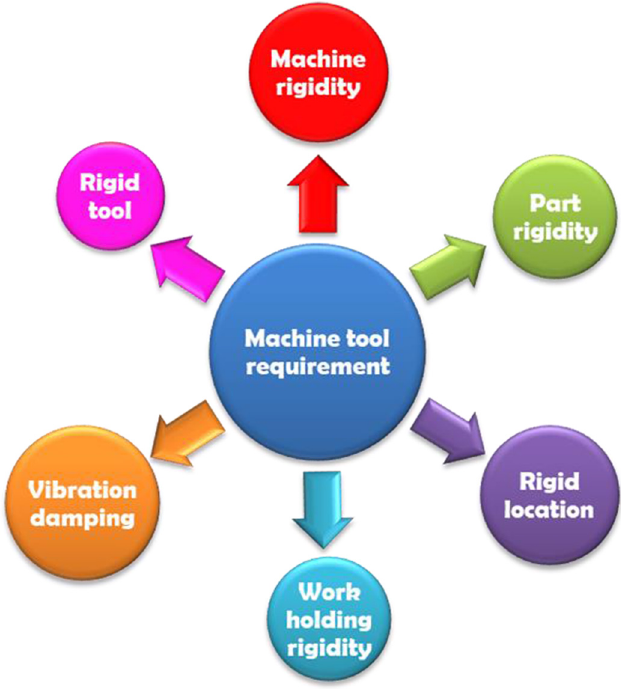
Fig. 4. Machine tool requirements in hard turning